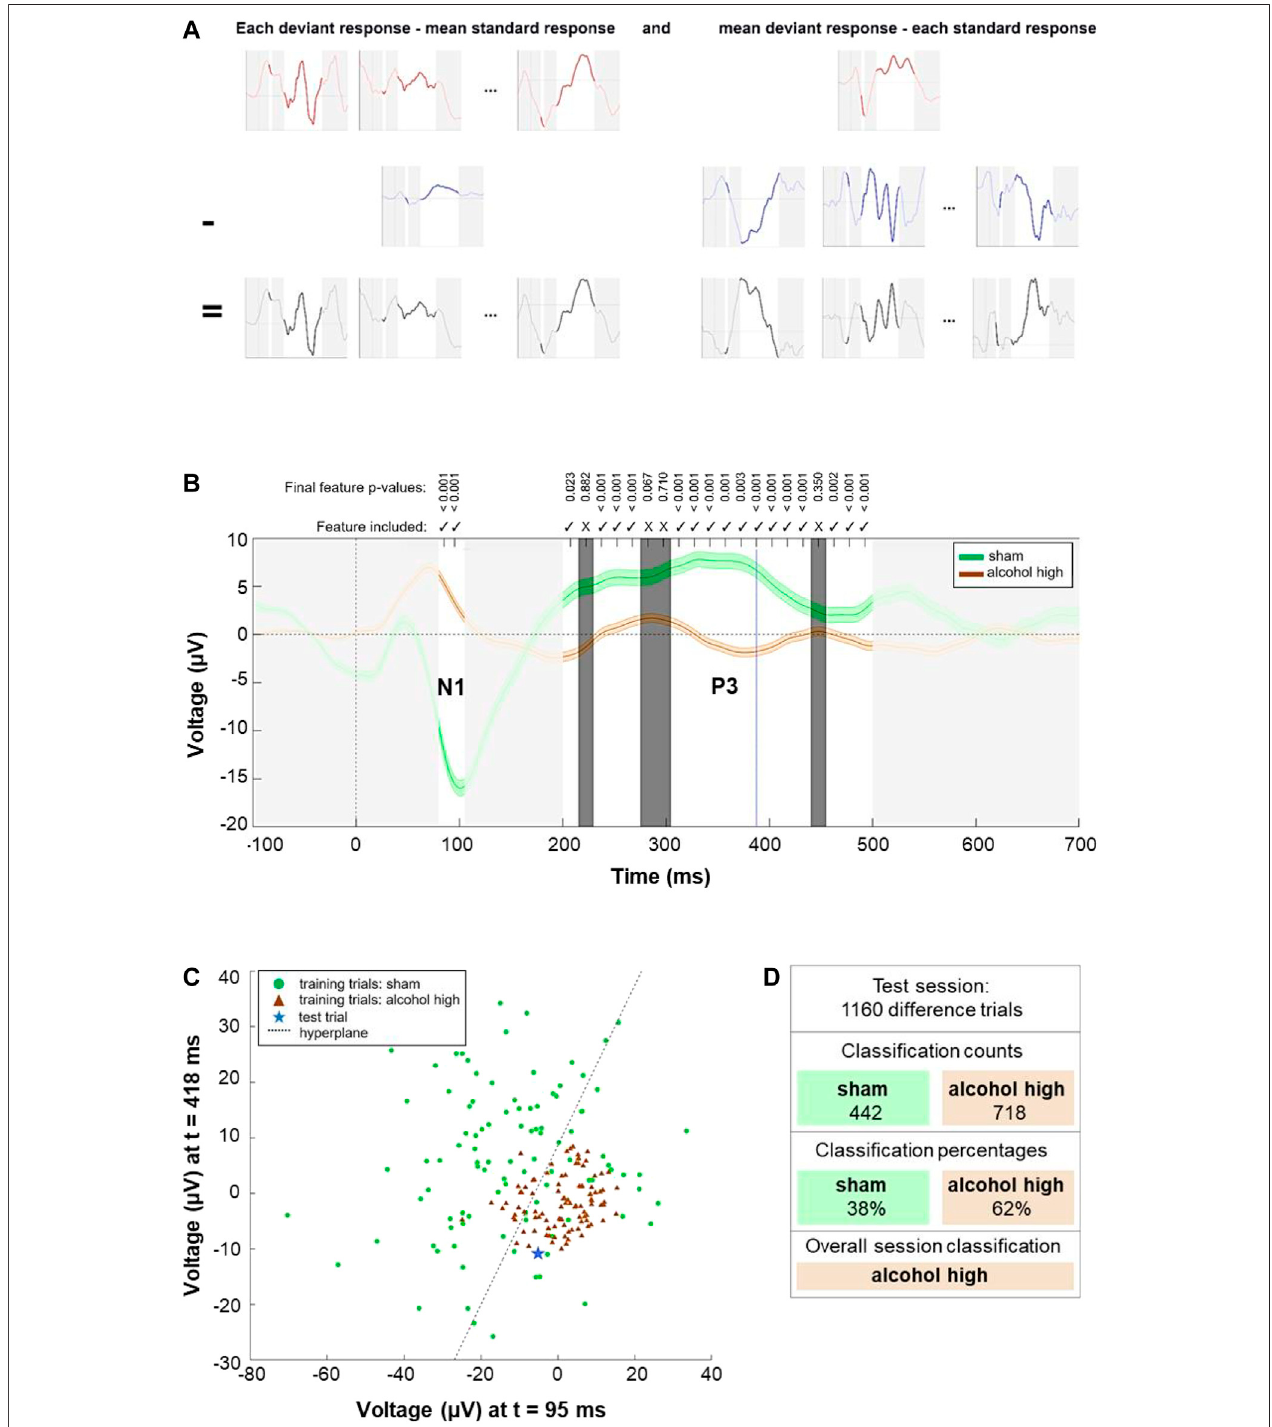
FIGURE5 | Approach to distinguish thetreatment applied foreach session. (A) Generation oftraining and test trials.Upper row (red): deviant ERP responsesfor a singleanimalandtreatment,includingthemean (right) .Midrow:standardERPresponses,includingthemean (left) .Bottomrow:resultingdifferencetrials.Timeranges not used for classi fi cation are obscured in light grey. (B) Session-level feature selection results. Representing a example model for testing whether the animal ’ s session canbecorrectlyclassi fi edas ‘ alcoholhigh ’ against ‘ sham ’ treatment.Solidgreenline:meanofalldifferencetrialsunder ‘ sham ’ treatment.Solidbrownline:meanof alldifferencetrialsunder ‘ alcoholhigh ’ treatment.Shadedareasaboveandbelowtheselinesrepresent1standarderror.Eachindividualfeaturerepresentsthevoltageat a given time point of each trial. For example, blue dotted line represents voltages of each trial at 388 ms post-stimulus. Time ranges, not eligible for classi fi cation, are